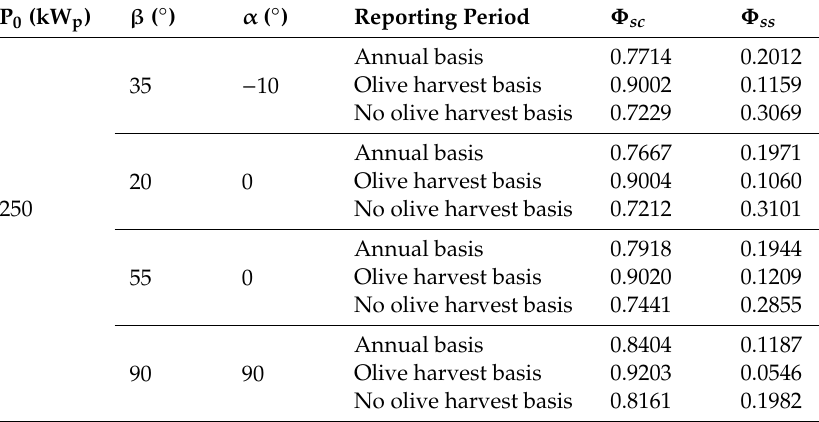
Figure 11. No harvest basis. Self-consumption and self-su ffi ciency curves as a function of P 0 . Figure 11 No harvest basis. Self-consumption and self-sufficiency curves as a function of P 0 . Table 5. Self-consumption and self-su ffi ciency indices with P 0 = 250 Table 5. Self-consumption and self-sufficiency indices with P 0 = 250 kWp.